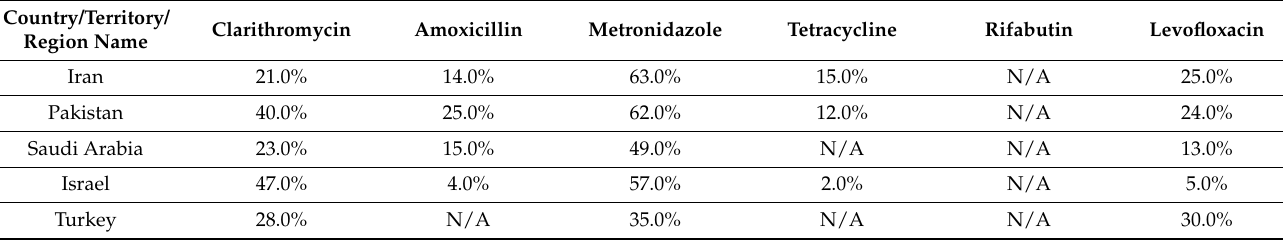
Table 5. Middle East Regional Rates of Resistance.